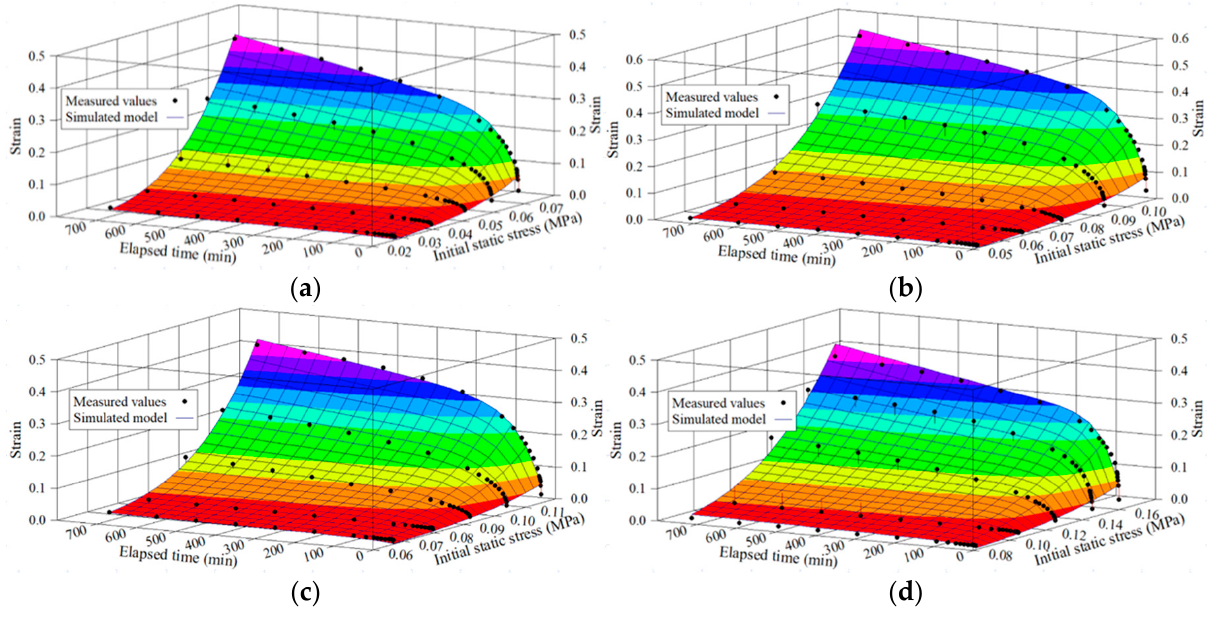
Figure 8. Response surface analysis for 12-h-long creep monitoring of EPS. ( a ) ρ = 16 kg/m 3 ; 0.0275 < σ o < 0.0683 MPa. ( b ) ρ = 20 kg/m 3 ; 0.0515 < σ o < 0.1067 MPa. ( c ) ρ = 25 kg/m 3 ; 0.0668 < σ o < 0.1154 MPa. ( d ) ρ = 30 kg/m 3 ; 0.0816 < σ o < 0.1600 MPa. Table 4. Nonlinear creep behavior modeling for 12-h-long creep experiment. Density